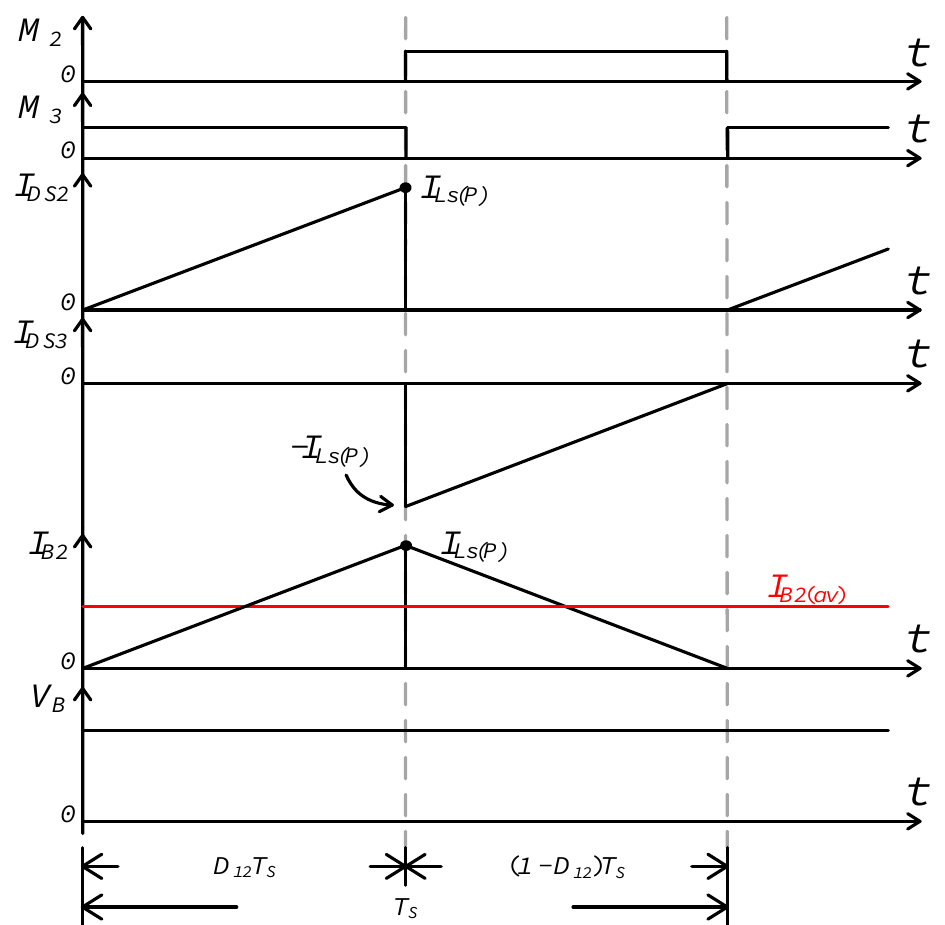
Figure 12. Ideal waveforms of inductor current I DS2 , I DS3 and I B2 of the proposed buck converter operated in the boundary of CCM and DCM.